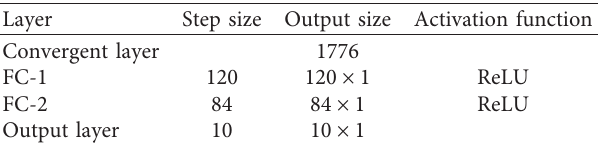
Table 3: Fully connected